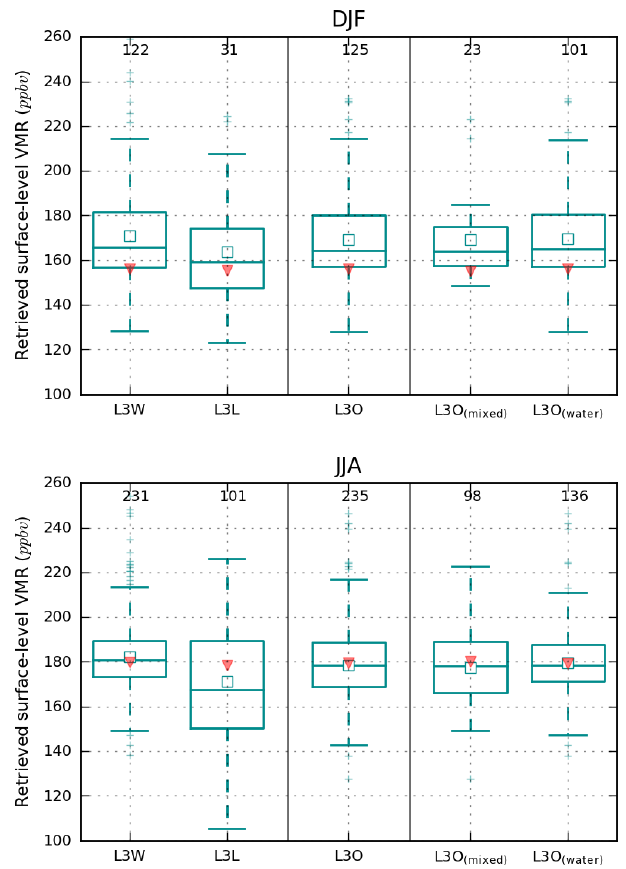
Figure 8. Boxplots showing the seasonal distribution of retrieved surface level VMR values from L3W, L3L, L3O, L3O ( mixed ) and L3O ( water ) . Squares represent mean values; red triangles represent corresponding mean a priori values. Sample sizes are given below the top x